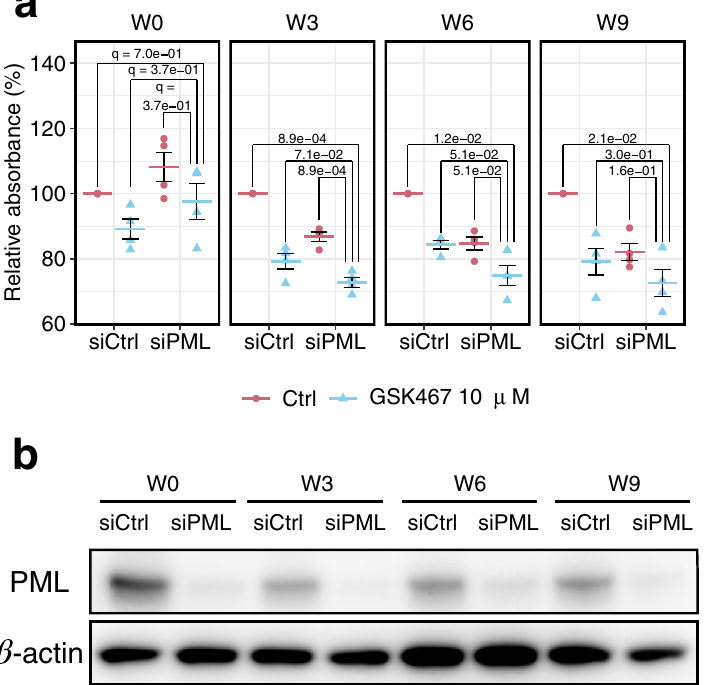
Figure 5. Experimental validation. ( a ) Effect of PML knockdown and KDM5 inhibitor GSK467 on the relative cell number of TAM-treated cells measured using MTT assay at each time point. siCtrl and siRNA indicate conditions in non-targeting siRNA-treated and those in siRNA targeting PML -treated, respectively. The data represent mean ± SE (n = 4). q-values were calculated using two-tailed Welch’s test. ( b ) Protein expression levels of PML in each condition. β-actin presented as a loading control. Whole membrane images are presented in Supplementary Fig.